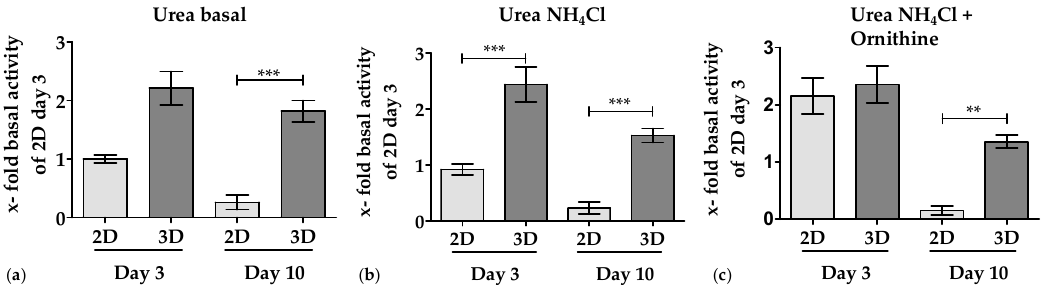
Figure 4. Urea production and ammonia detoxification. ( a ) Basic urea production by PHHs over 24 h in 2D (bright bars) and 3D (dark bars) cultures. ( b ) Urea production by PHHs after 24 h following the incubation with NH 4 Cl in 2D (bright bars) and 3D (dark bars) cultures. ( c ) Urea production by PHHs after 24 h incubation with NH 4 Cl plus ornithine in 2D (bright bars) and 3D (dark bars) cultures. Data were normalized to the resazurin conversion (viable cells). Data represent an average of N = 3 independent experiments ( n = 3). Bars represent mean ± SEM ** p ≤ 0.01; *** p ≤ 0.001 as indicated.